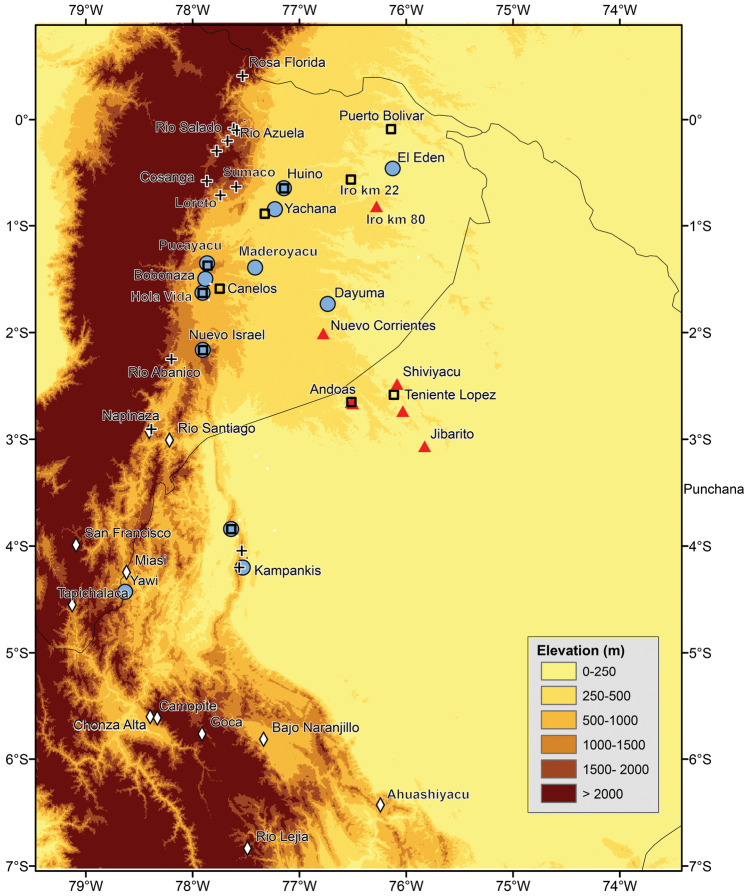
Records of Osteocephalus cannatellai, Osteocephalus festae, Osteocephalus mutabor, Osteocephalus verruciger, and Osteocephalus vilmae. Osteocephalus cannatellai, circles; Osteocephalus festae, diamonds; Osteocephalus mutabor, squares; Osteocephalus verruciger, crosses; and Osteocephalus vilmae, triangles. Locality data from the literature (Duellman and Mendelson 1995; Jungfer 2010; Peracca 1904; Ron et al. 2010) and specimens deposited at Museo de Zoología of Pontificia Universidad Católica del Ecuador, the Herpetology Collection, Escuela Politécnica Nacional, and Centro de Ornitología y Biodiversidad CORBIDI.